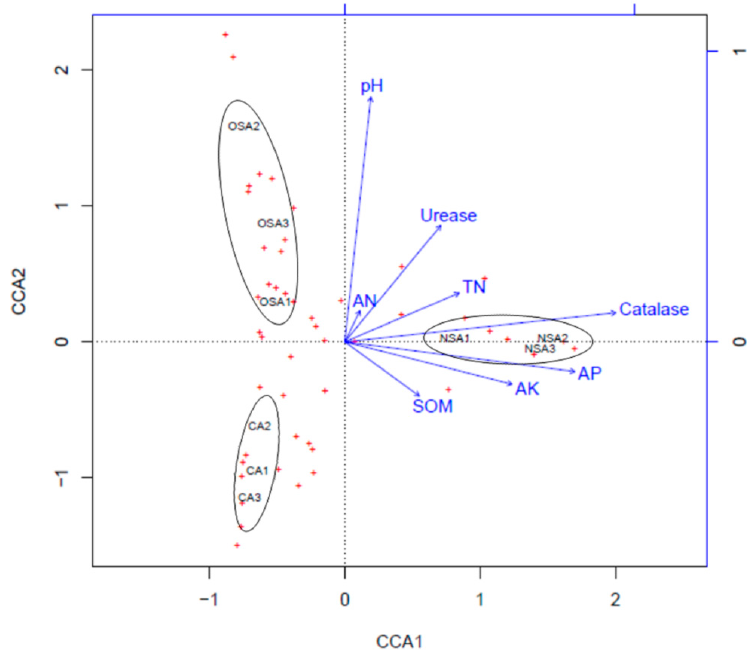
Figure 6. CCA ordination of fungal community with the environmental factors in the soils.